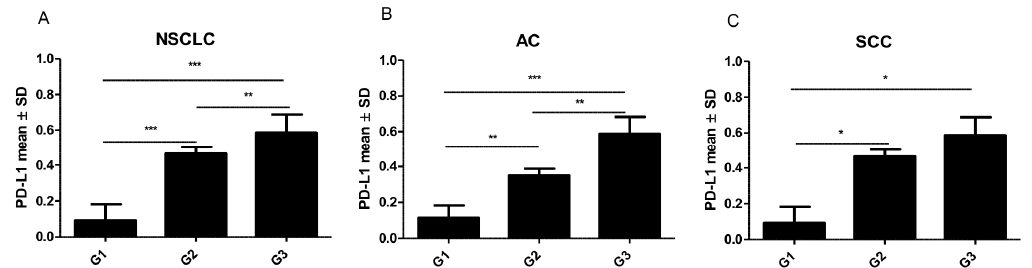
Figure 3. The higher the grade (G) of malignancy, the higher the PD-L1 expression observed. Comparison of PD-L1 protein expression levels in different grades of malignancy (G) of non-small cell lung cancer (NSCLC) ( A ), adenocarcinoma (AC) ( B ), squamous cell cancer (SCC) ( C ) * p ≤ 0.05, ** p ≤ 0.01, *** p ≤ 0.001.